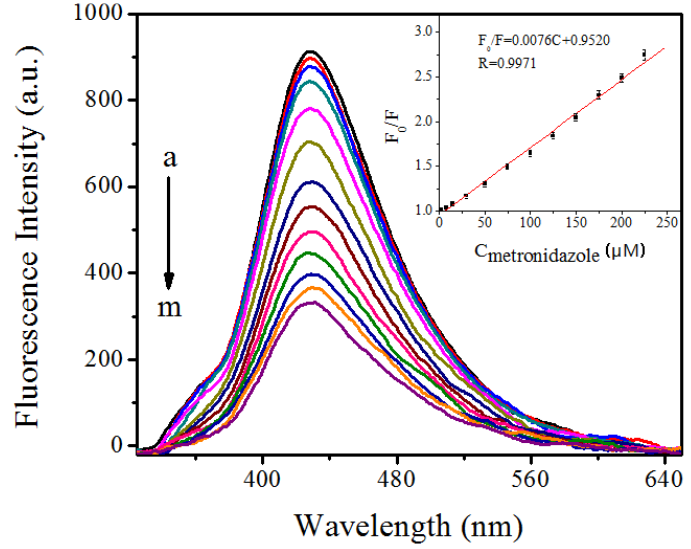
Figure 10. The change in fluorescence intensity of FCNs upon the addition of various concentrations of MNZ. The concentrations of MNZ are as follows: ( a ) 0.00; ( b ) 2.50; ( c ) 7.50; ( d ) 15.00; ( e ) 30.00; ( f ) 50.00; ( g ) 75.00; ( h ) 100.00; ( i ) 125.00; ( j ) 150.00; ( k ) 175.00; ( l ) 200.00; and ( m ) 225.00 μM. Conditions: PBS, 0.2 M, pH = 7.0; FCNs: 500 μL.